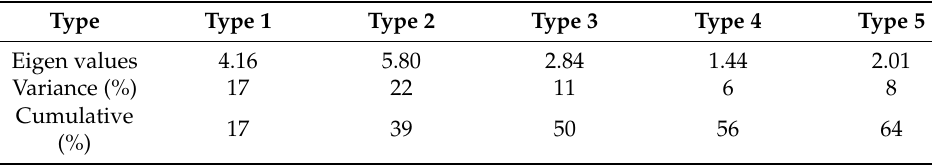
Table 3. Eigen value and variance according to type.